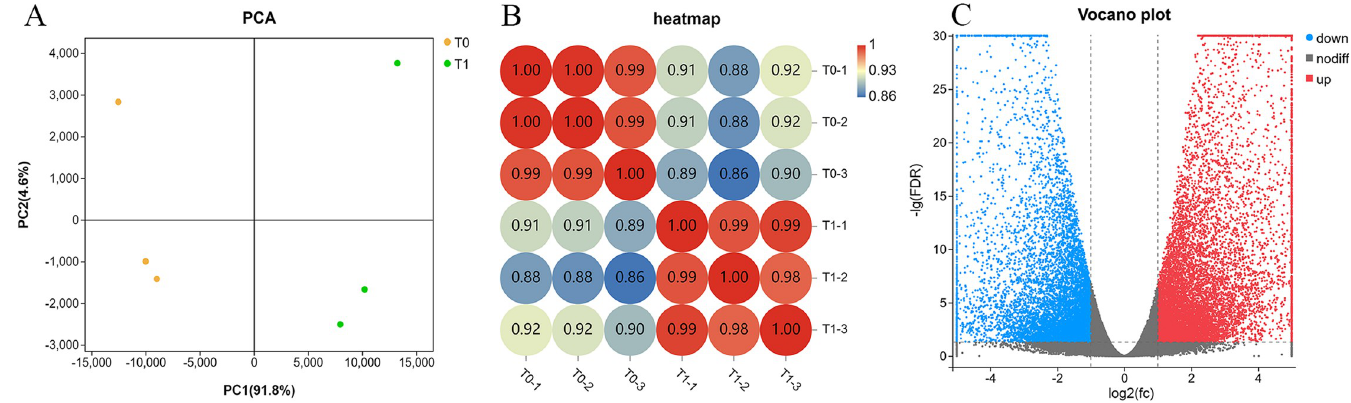
Fig 3. Sample relationship analysis and differentially expressed genes. (A) Principal components analysis. (B) r 2 analysis to test repeatability. (C) Statistics of differentially expressed genes. Blue represents downregulated unigenes, and red represents upregulated unigenes.